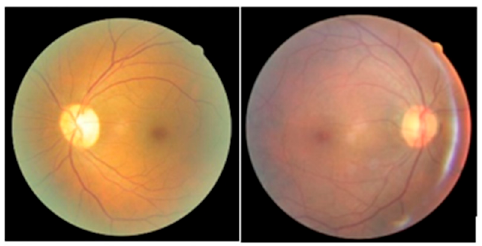
Figure 4. Two randomly picked fundus images from the training data set that feature oppositely oriented retinas.